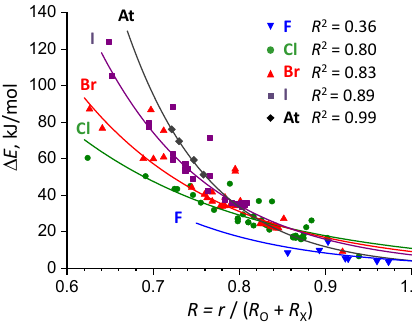
Figure 5. Correlation between calculated complexation energy ∆ E and normalized distance parameter R = r / ( R O + R X ), where r is X ··· O distance and R O and R X are van der Waals radii of oxygen and halogen atoms, respectively, for R–X ··· O = PMe 3 halogen-bonded complexes studied in this work (X = F, Cl, Br, I, and At). The solid curves correspond to Equation (3).